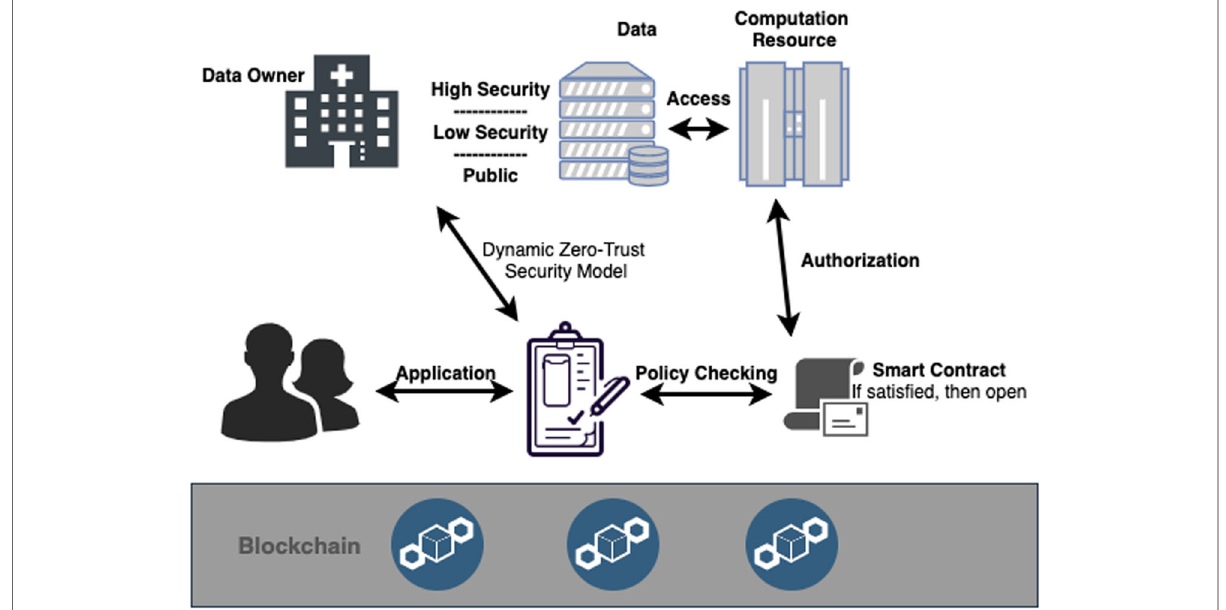
Fig. 6 Virtual remote computing supported by